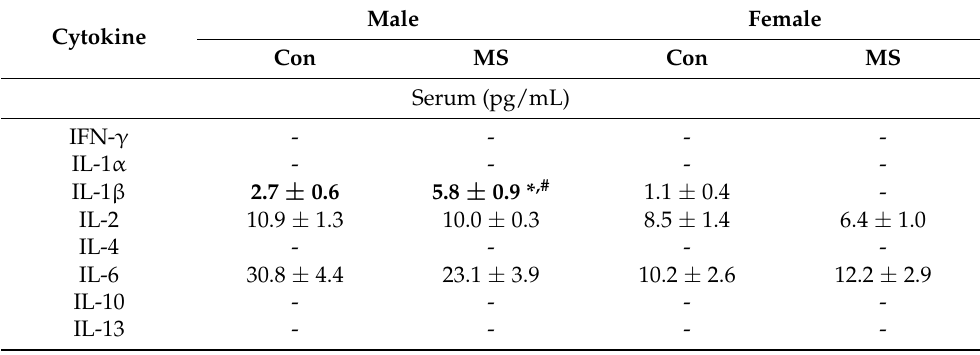
Table 1. Cytokine levels in the serum, colon and hippocampus of MS rat.